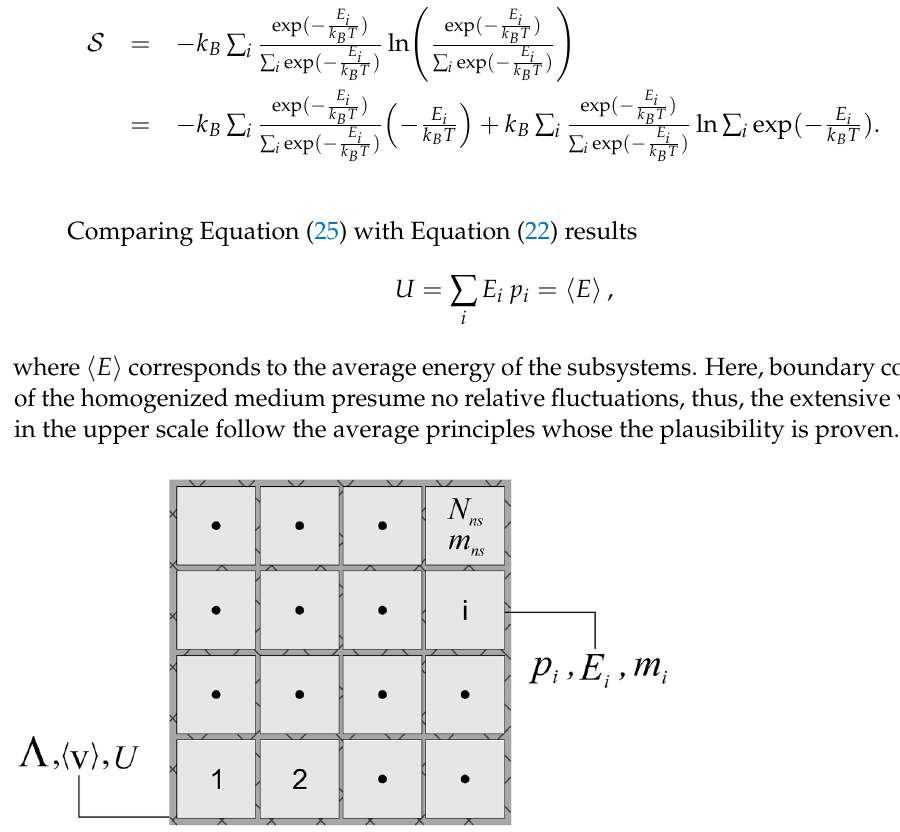
Figure 2. Schematic representation of a microcanonical ensemble with equal probability of state, p i , and energy, E i , of each subsystem in the total volume, Λ , with the average velocity of (cid:104) v (cid:105) and energy U